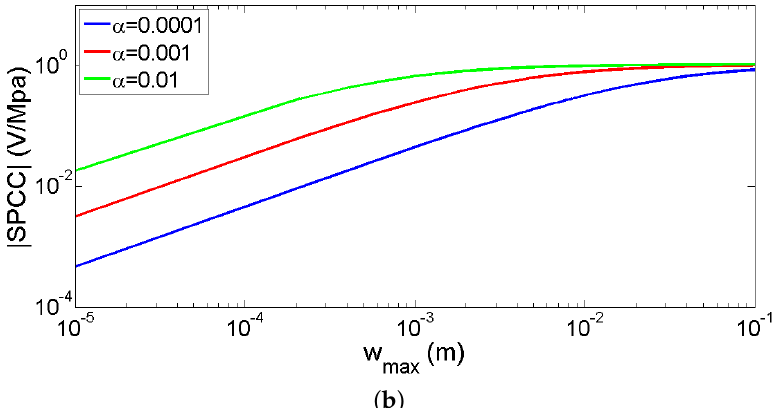
Figure 6. The variation of the SPCC with the fracture aspect ratio β and the maximum width w max predicted from Equation (37) for three values of α (0.0001, 0.001 and 0.01) with representative values of σ w = 2 × 10 − 2 S/m, Σ s = 1 × 10 − 9 S, ζ = − 30 mV, φ = 0.15: ( a ) w max is fixed at 200 × 10 − 6 m and ( b ) β is fixed at 0.001.